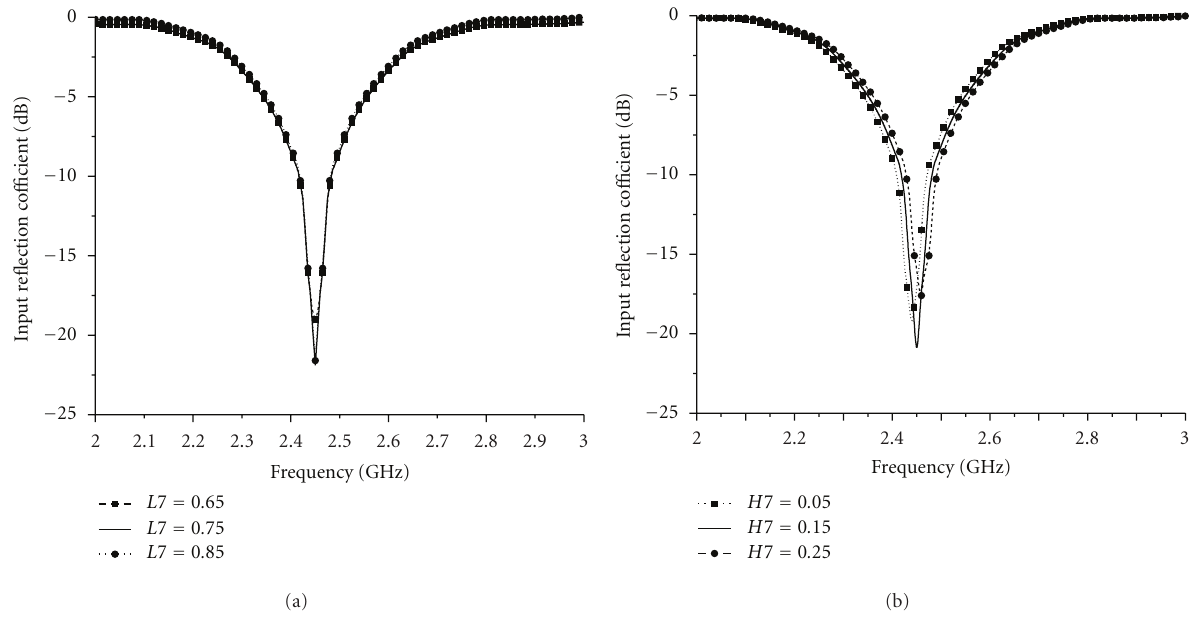
Figure 6: The input reflection coe ffi cient changes with the length L 7 and width H